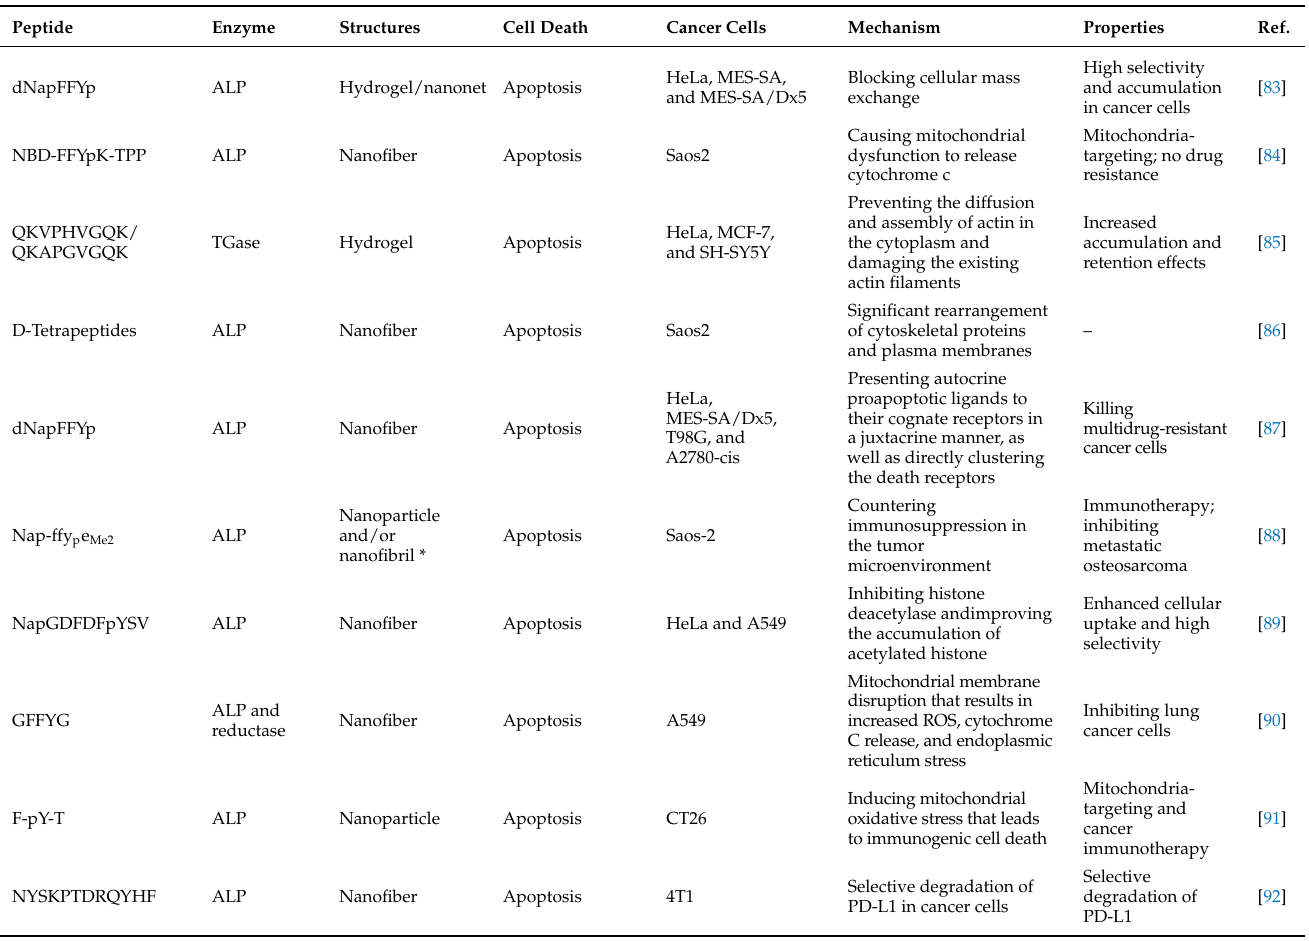
Table 1. IEISAP materials used as anticancer drugs